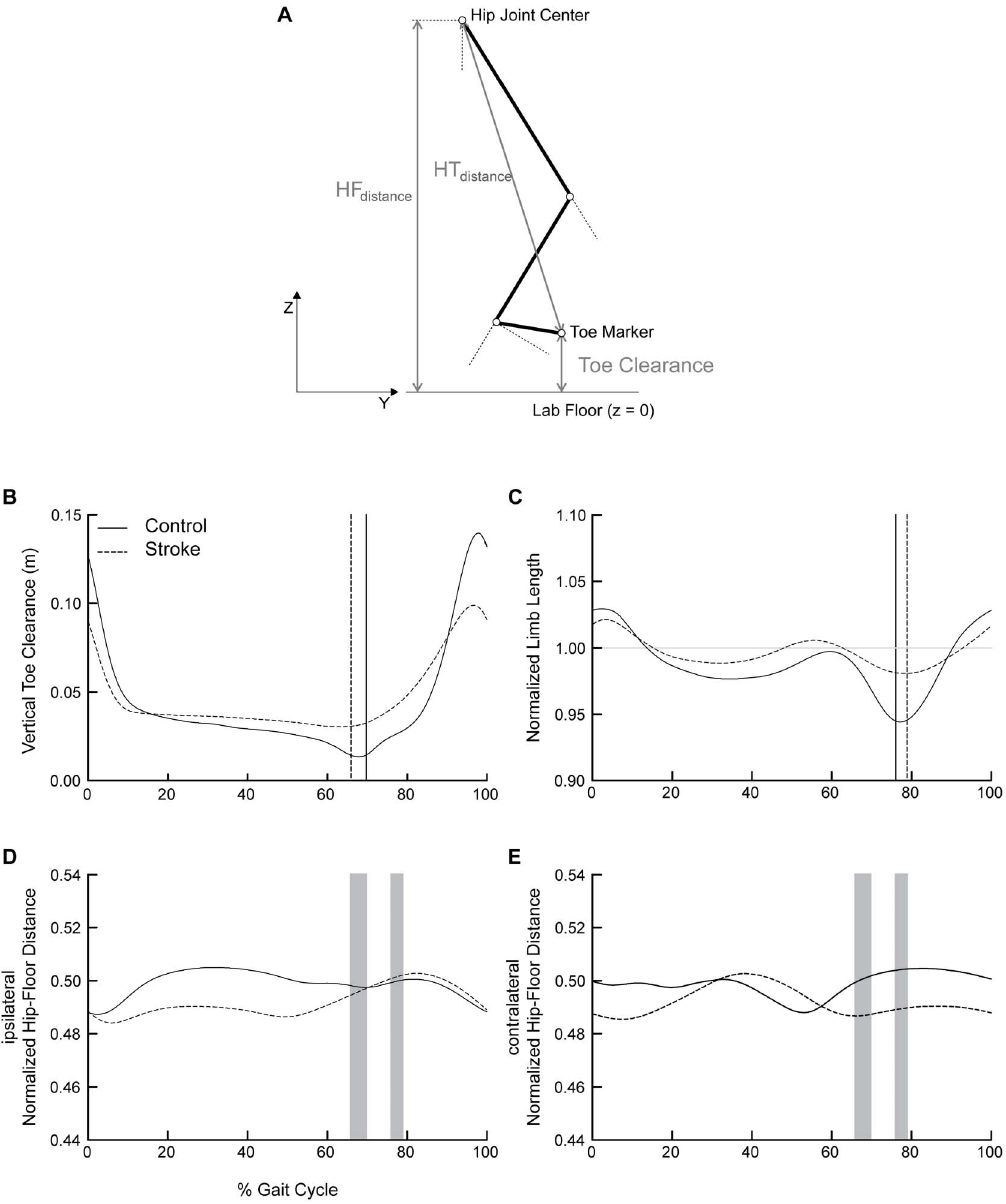
Figure 1. Gait events and hip-floor height. (a) Toe clearance served as our indicator of limb clearance. We used the trajectory of the distal toe marker to quantify toe position. Minimal toe clearance (TC min ) was defined as the lowest vertical position of the trajectory of the toe marker during swing. Normalized limb length was calculated as the instantaneous hip-toe distance (HT distance ) divided by the instantaneous vertical distance from the hip joint center to the floor (HF distance ). [30] Limb shortening was quantified as the percent reduction in normalized limb length relative to the instantaneous height of the hip joint center. Maximal limb shortening (LS max ) was defined as the highest percent reduction in normalized limb length during swing. (b) The vertical trajectory of the great toe marker, time normalized to the gait cycle. (c) Normalized limb length quantified as the hip- toe distance divided by the hip-floor distance. Values less than 1 indicate limb shortening. (d) Ipsilateral and (e) contralateral normalized hip-floor height quantified as the hip-floor height divided by the participant’s height. Controls are depicted in solid black, with participants post-stroke depicted with dashed lines in all panels. Vertical cursor lines represent: minimal toe clearance (b) and maximal limb shortening (c) for each group. Grey shaded regions (d and e) represent the range (across groups) of timing for minimal toe clearance (1 st ) and maximal limb shortening (2 nd ). doi:10.1371/journal.pone.0110140.g001 and distal toe marker ( see Equation 15 ). [30] Again, the partial derivative with respect to the contributing joints (i.e., knee and Hip flexion, knee flexion, and ankle dorsiflexion were assessed at ankle) quantifies the relative contribution of the knee and ankle to two events of interest during the swing phase of gait: minimum toe limb shortening ( see Equations 16–17 ). [30]. clearance (TC min ) and maximal limb shortening (LS max ). The gait events TC min and LS max were identified and their timing, relative to the gait cycle, analyzed (Figure 1, panels b–c). To account for